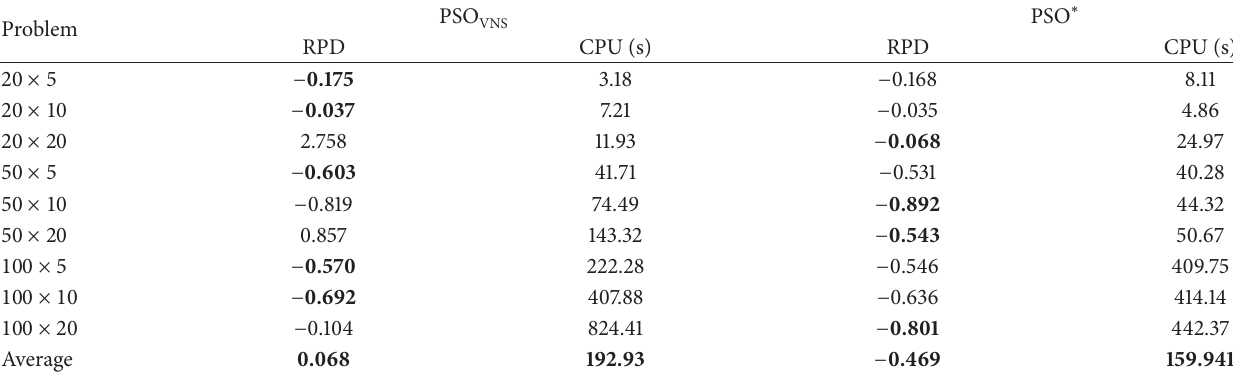
and PSO ∗ for total flowtime VNS